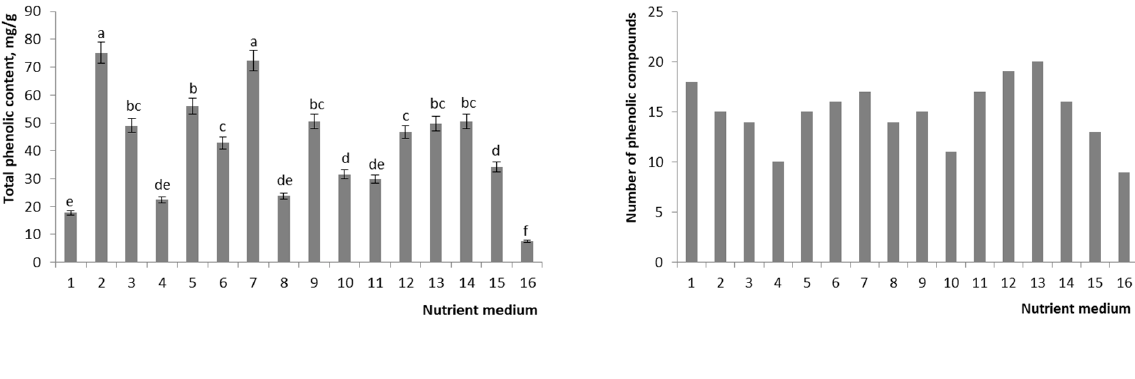
Figure 3. Effect of composition of the nutrient medium and different concentrations of MJ on ( A ) total phenolic content and ( B ) number of phenolic compounds in callus cultures of R. rosea. Values are mean ± standard error (vertical error bars) of three replicates. Means with similar letters are not significantly different at p ≤ 0.05 according to LSD test. Legend. Treatment group 1: NH 4+ /K + 0.33,